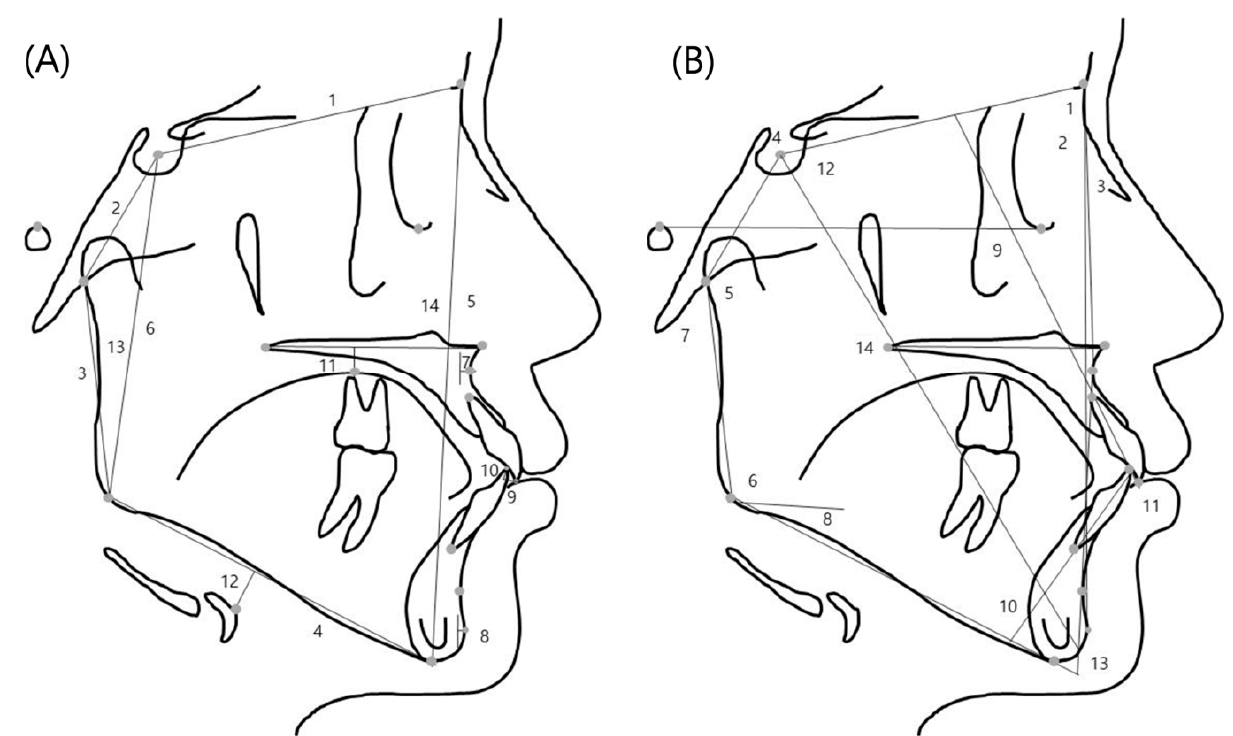
Figure 1. ( A ) Linear variables used in this study: 1, anterior cranial base (ACB); 2, posterior cranial base (PCB); 3, ramus height (RH); 4, mandibular body length (MBL); 5, anterior facial height (AFH); 6, posterior facial height (PFH); 7, point A to N perpendicular (A to N-perp); 8, pogonion to N perpendicular (Pog to N-perp); 9, overjet (OJ); 10, overbite (OB); 11, dorsum of the tongue to palatal plane (Tp to PP); 12, hyoidale to mandibular plane (H to MP); 13, body to anterior cranial base ratio (body to ACB); 14, facial height ratio (FHR). ( B ) angular variables used in this study: 1, SNA angle; 2, SNB angle; 3, ANB angle; 4, saddle angle; 5, articular angle; 6, gonial angle; 7, Björk sum; 8, Frankfort horizontal plane to mandibular plane angle (FMA); 9, upper incisor to FH angle (U1 to FH); 10, incisor mandibular plane angle (IMPA); 11, inter-incisor angle (IIA); 12, Y-axis to SN angle; 13, AB plane to mandibular plane angle (AB to MP); 14, palatal plane to Frankfort horizontal plane angle (PP to FH).